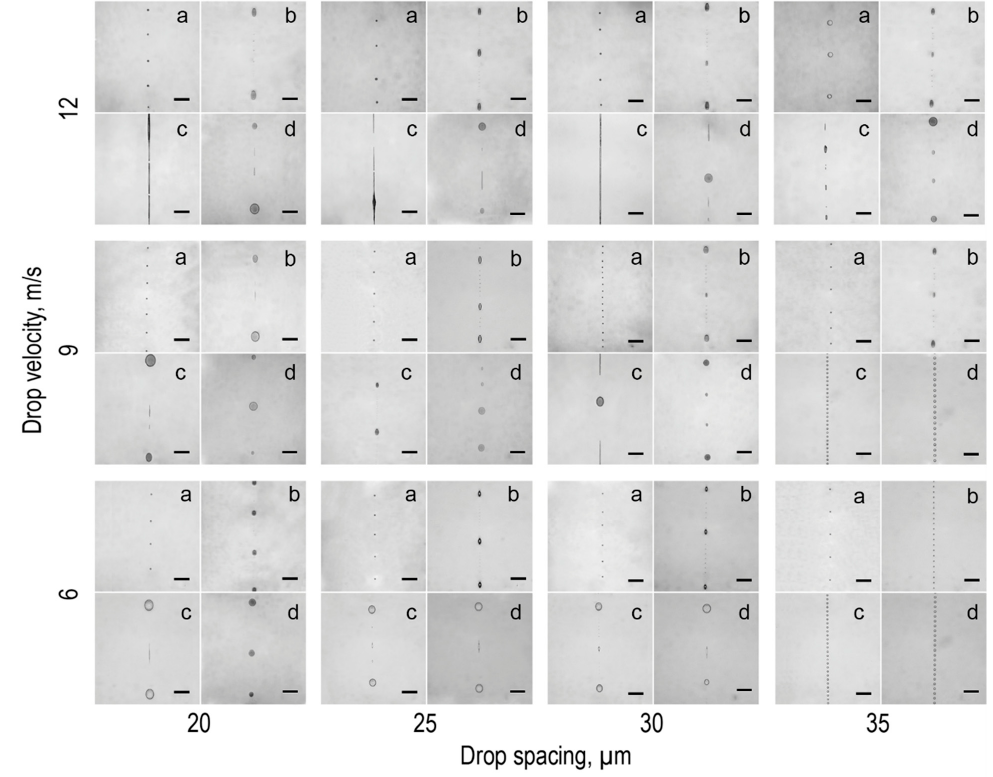
Figure 2. Array of optical images of a 1 pxl line printed on poly(dimethylsiloxane) (PDMS) ( a ) uncured, ( b ) cured for 3 min, ( c ) cured for 5 min, and ( d ) cured for 7 min, all at 80 °C as a function of drop spacing and release velocity. The scale bar is 100 µm.